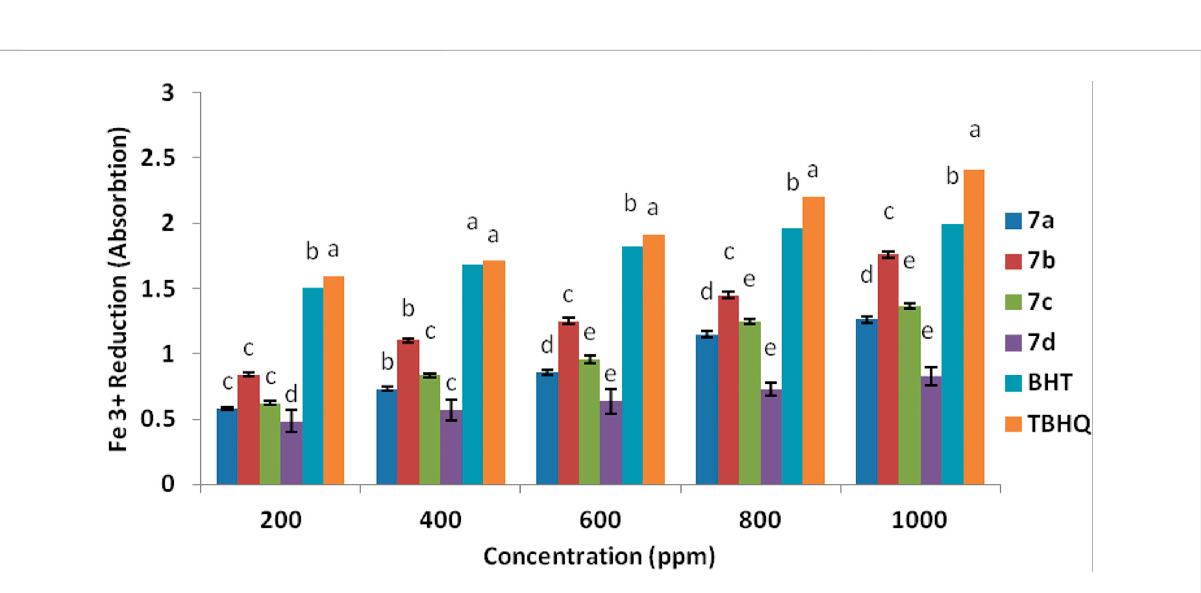
FIGURE 6 Order of antioxidant activity of 7a-7d using